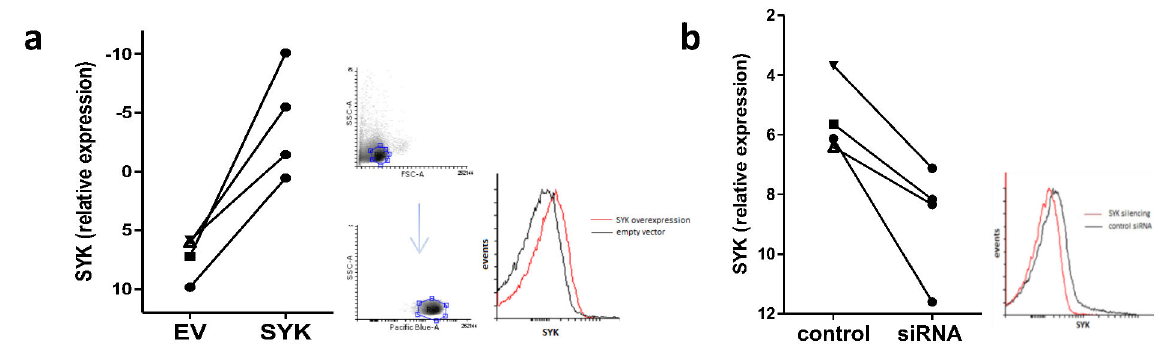
Figure 1. Induced Syk expression and Syk silencing in T cells. a) T cells extracted from healthy blood-donors were transfected with either a SYK (SYK) or an empty (EV) expression vector. Following 72h of incubation, cells were lysed, RNA extracted and SYK expression levels measured in real-time PCR. SYK overexpression led to a significant increase in its mRNA levels in all four experiments tested (left panel, normalized expression levels shown). To investigate whether this finding translates into protein expression levels as well, whole T cells were used to be analyzed in flow cytometry. Syk protein was found to significantly increase following SYK overexpression in all experiments tested (right panel, a representative plot is shown, plots gated on CD3+ T cells). b) T cells extracted from SLE patients were transfected with either a SYK-specific (siRNA) or a control (control) siRNA and expression levels of Syk were measured using real-time PCR and flow cytometry. The SYK silencing protocol led to a significant reduction in its expression at both the mRNA (left panel) and protein levels (right